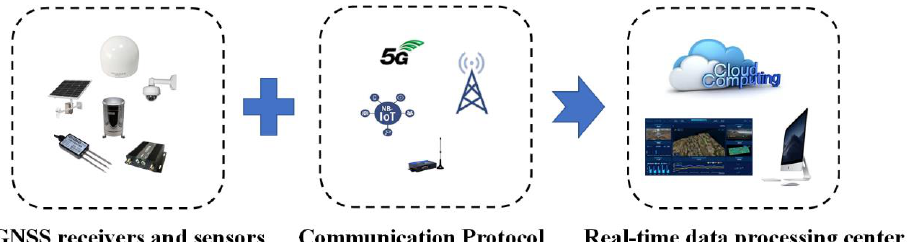
Figure 23. Design idea of GNSS integrated landslide monitoring system.